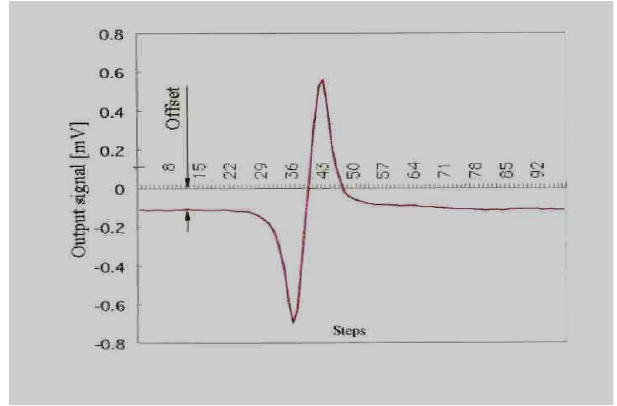
Figure 27. Amplitude of the voltage across sensing coil with a defect in the